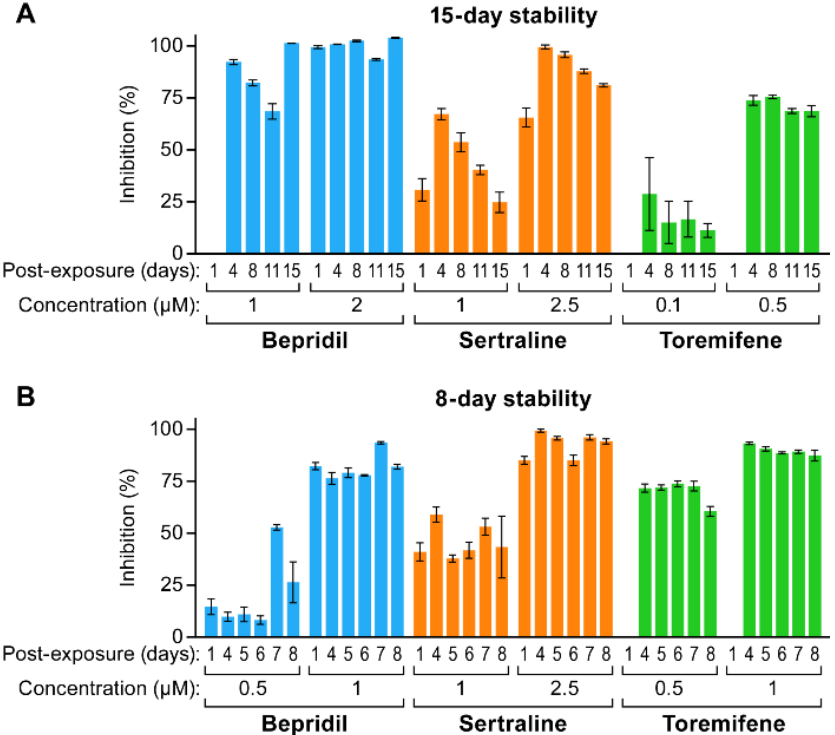
Figure 2. Activity of bepridil, sertraline and toremifene in V8 against VSV-EBOV-GP ∆ -Luc over time. Bepridil-HCl (50 mg/mL), sertraline-HCl (6 mg/mL), and toremifene citrate (8.5 mg/mL) were prepared in V8 on day 1 (d1) as described in the Supplementary Document, and stored at 4 ◦ C for ( A ) 15 or ( B ) 8 days. On the indicated day the stock was brought to RT. HEK293T/17 cells were pretreated with drugs as indicated, infected with VSV-EBOV-GP ∆ -Luc, and scored for infection as described in the Methods section. All samples were analyzed in triplicate, and the data are averages +/ − sd.